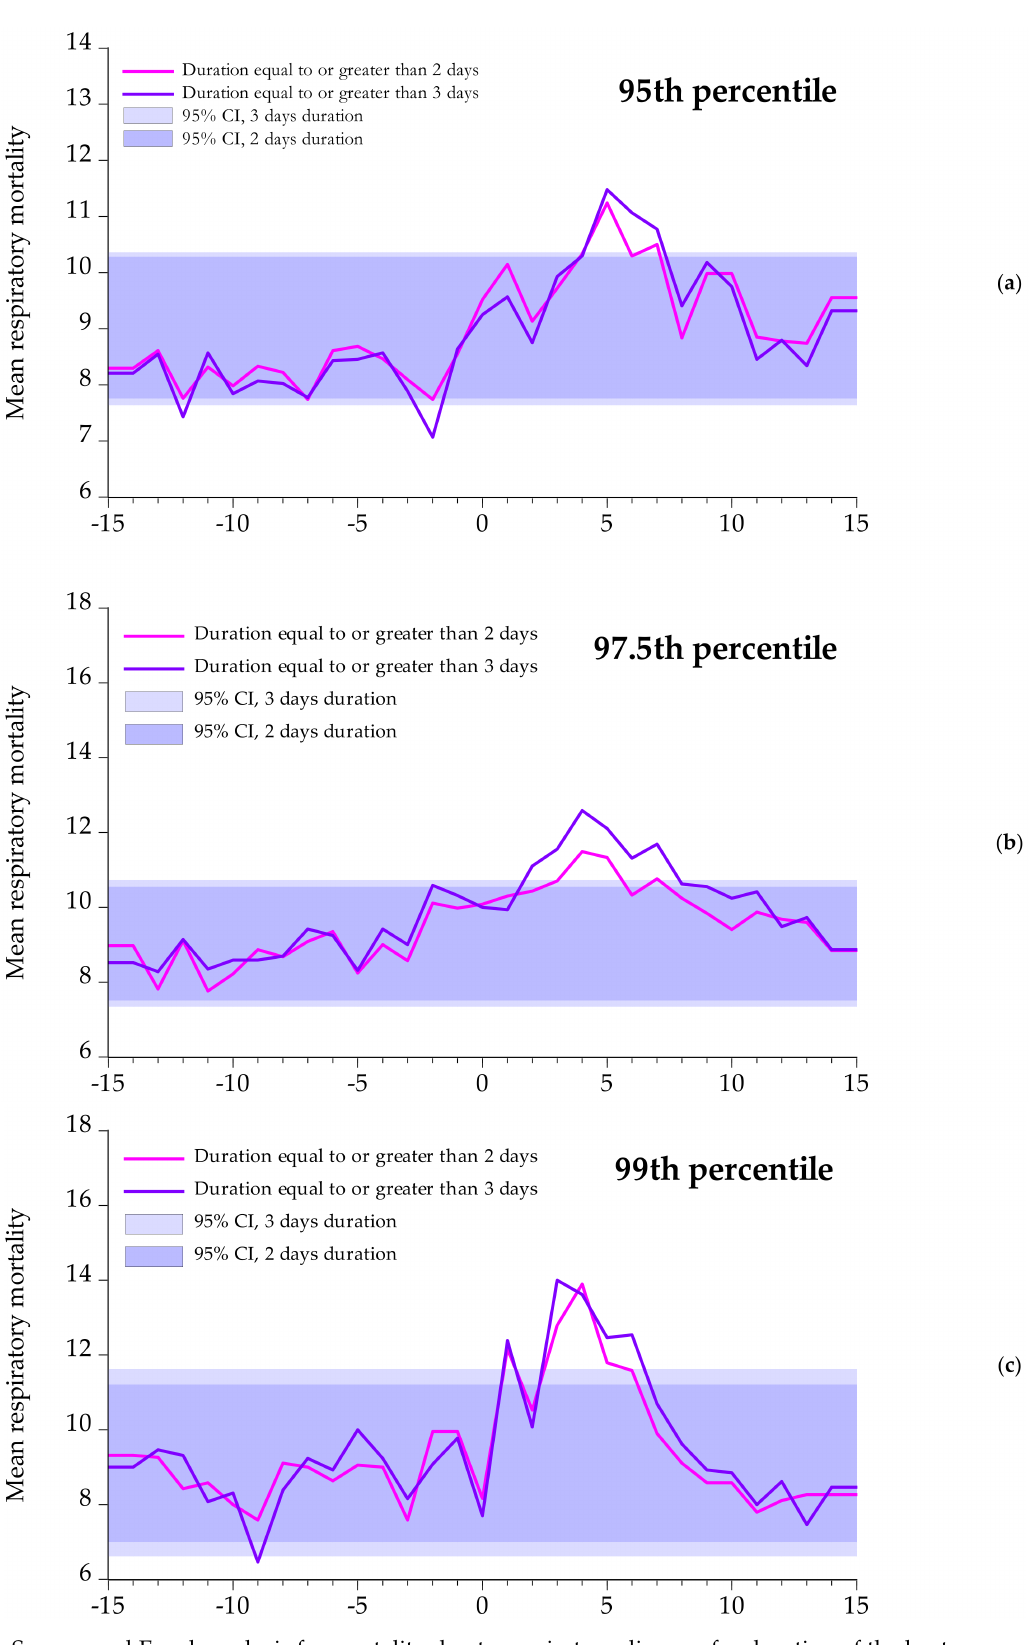
Figure 7. Superposed Epoch analysis for mortality due to respiratory diseases for duration of the heatwave event of at least 2 and 3 days: ( a ) 95th percentile; ( b ) 97.5th percentile; ( c ) 99th percentile. Notes: (i) The shaded area shows the 95% Confidence Interval (CI), (ii) the vertical axis measures the mean number of deaths due to respiratory diseases, (iii) the horizontal axis depicts the time 15 days before and 15 days after the heatwave event. Day 0 is the first day of the